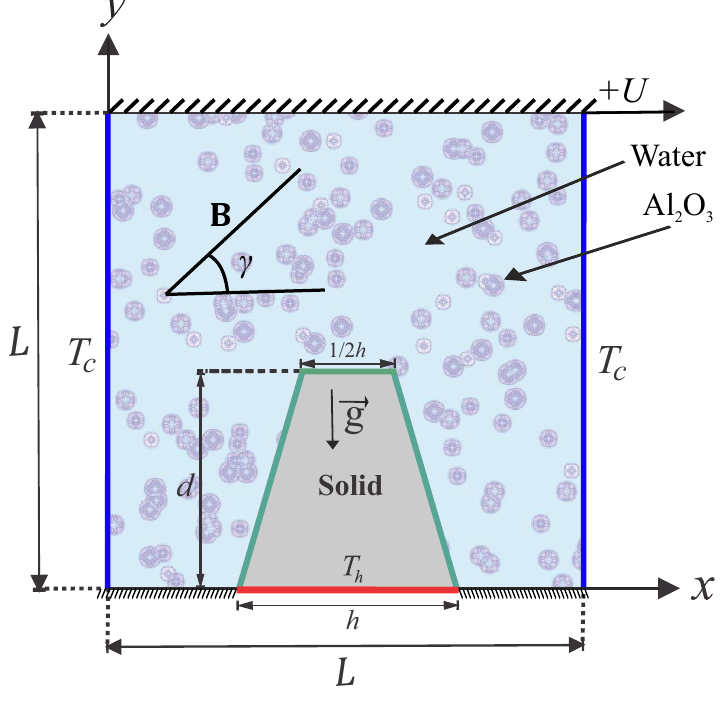
Figure 1. Sketch of the problem